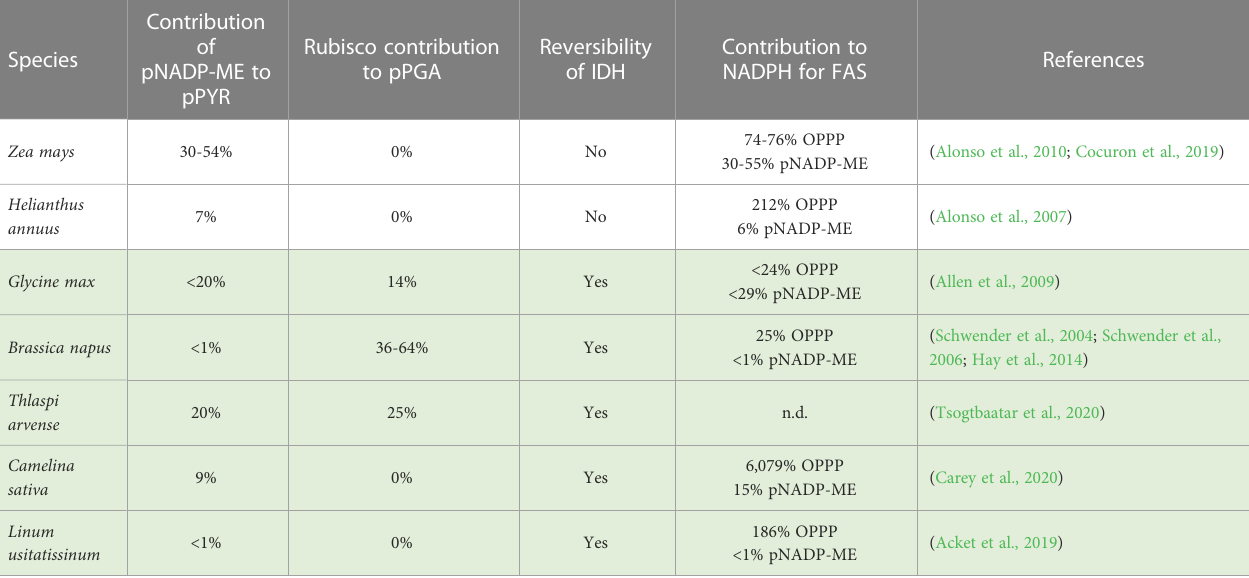
TABLE 2 Comparison of the use of non-conventional pathways in developing